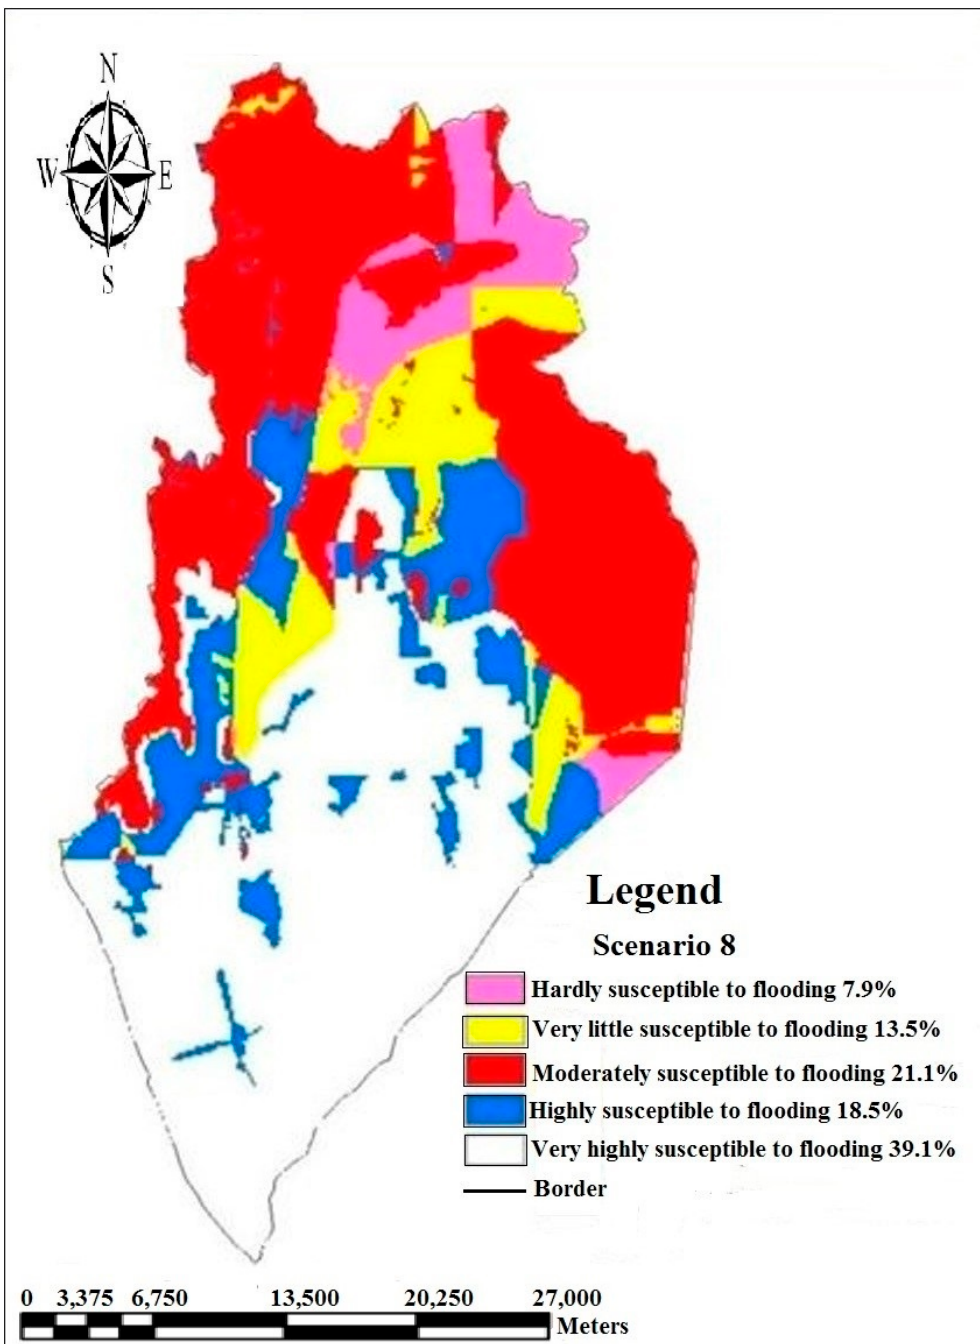
Figure A2. Importance of paddy fields (Scenario 8).